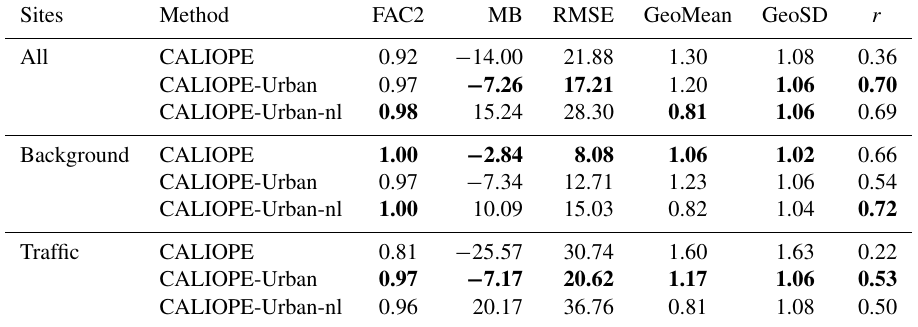
Table 5. NO 2 model evaluation statistics calculated at 182 passive dosimeter valid sites (described in Sect. 3.2) during 2 weeks from 28 February to 15 March 2017 for CALIOPE, CALIOPE-Urban and CALIOPE-Urban-nl mean concentrations. Bold numbers represent model results with better performance for each statistic and site. Results are shown for all (including traffic and urban background), only urban background and only traffic